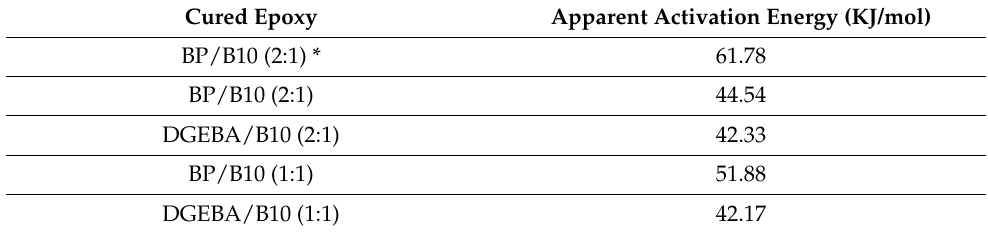
Table 11. Apparent activation energy of cyanate ester-cured epoxy